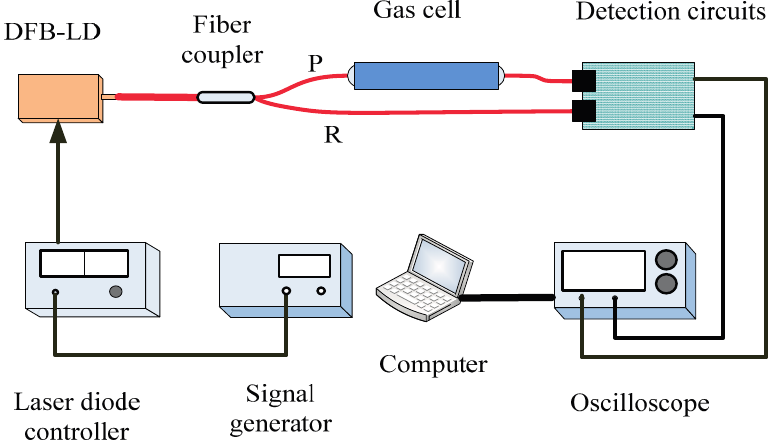
Figure 1. Structure diagram of TDLAS system: DFB-LD, distributed feedback laser diode; P, R, probe and reference light